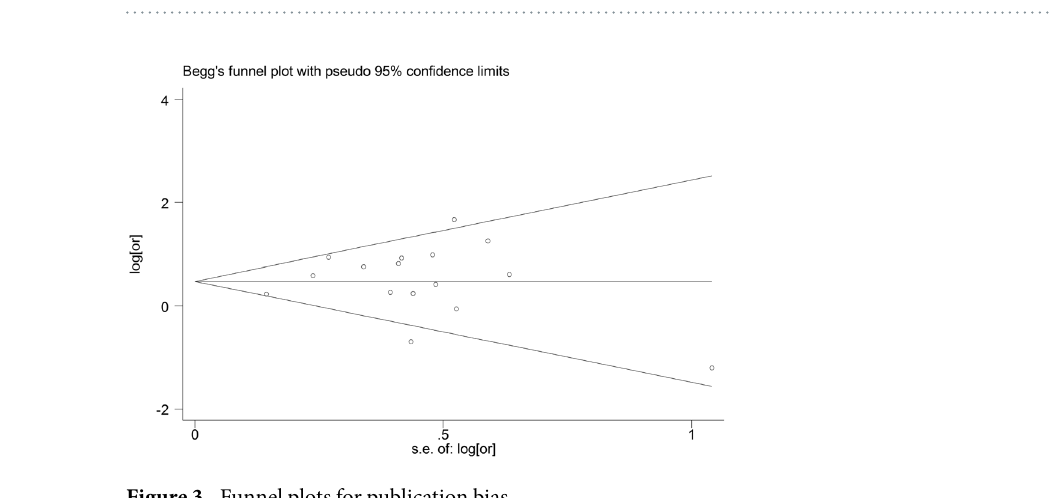
Figure 3. Funnel plots for publication bias.